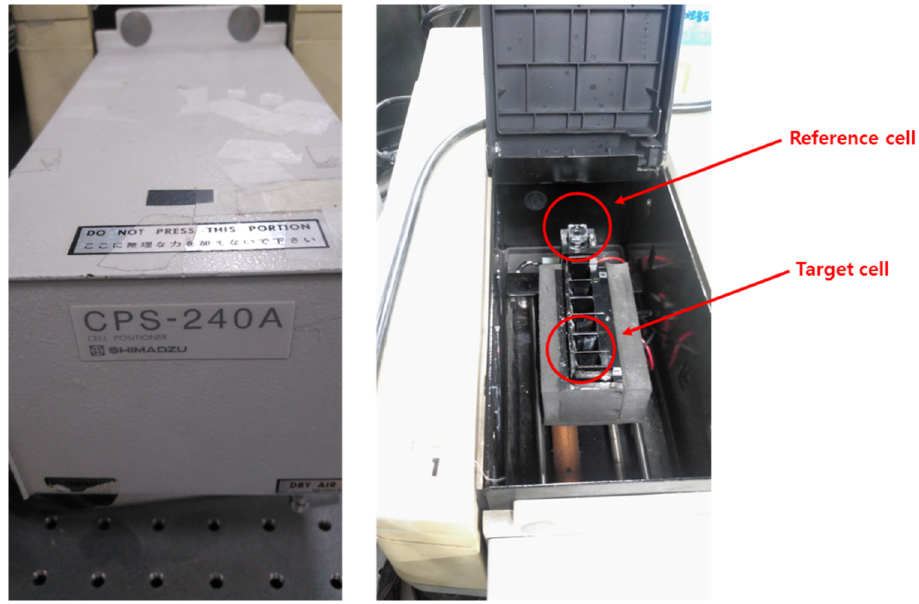
Figure 4. UV-Vis spectrometer for measuring colorized analyte’s absorbance.